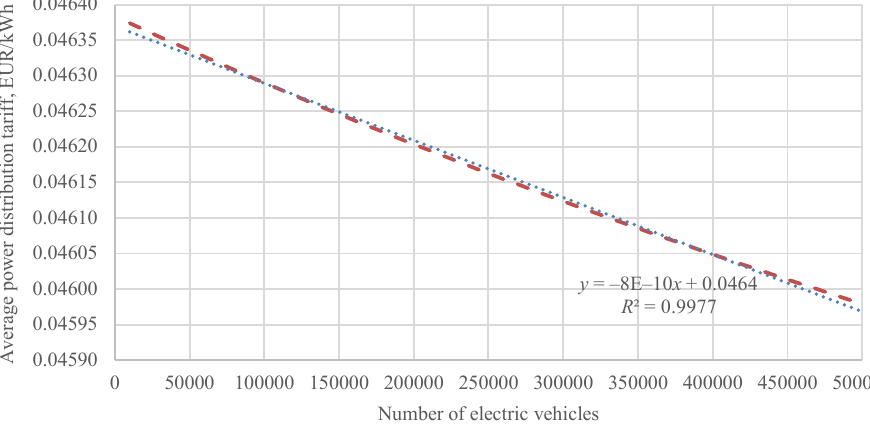
Fig. 1. Average power distribution tariff depending on number of electric vehicles in Latvia (regression function is the dotted